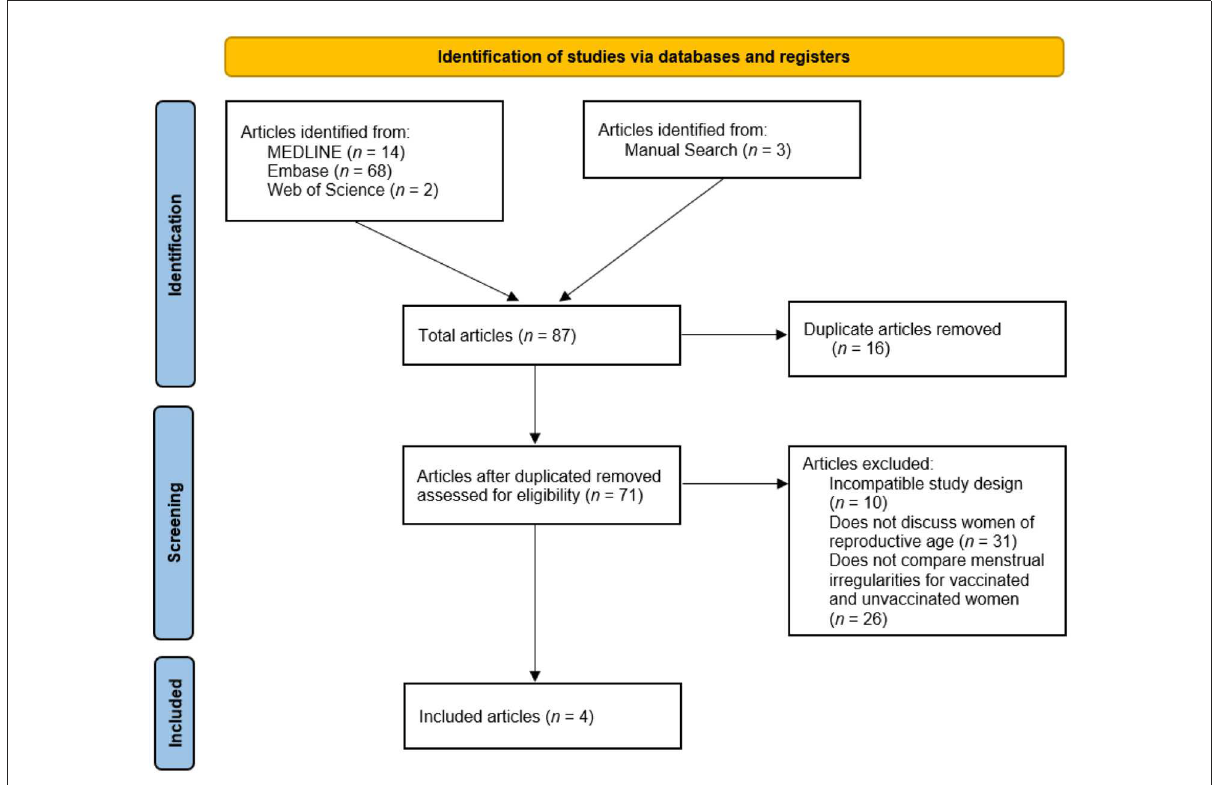
FIGURE1 PRISMA flow diagram for systematic